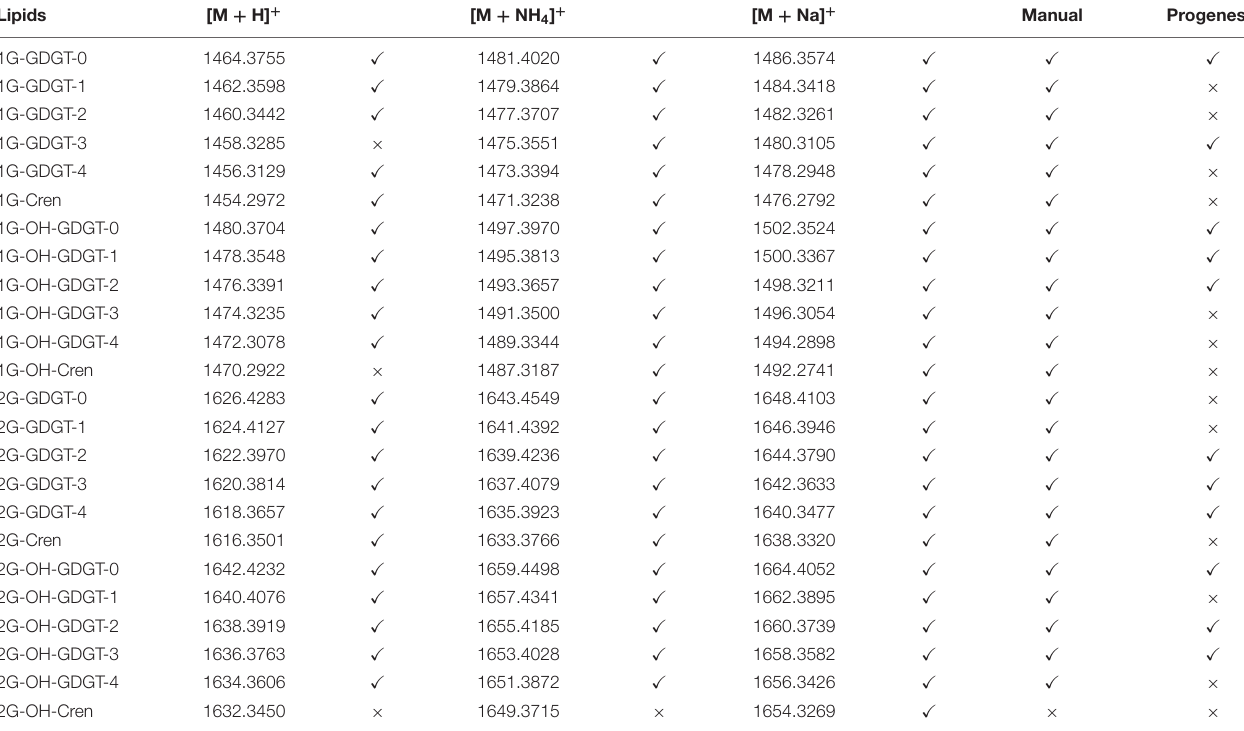
TABLE 2 | Manual curation using an accurate mass and retention approach.